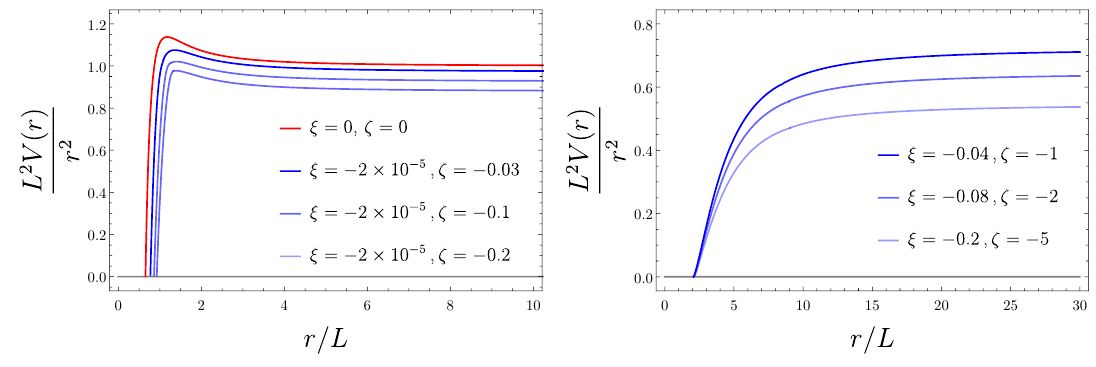
Figure 13 . The metric function L 2 V CP 2 ( r ) =r 2 is plotted for bolt solutions of the quartic theories. The left plot is for di(cid:11)erent combinations of the quartic couplings with n=L = 7 = 100. For this value of the NUT parameter, the bolt solutions in the quartic theories can be compared to Einstein gravity solutions. In the right plot, the NUT parameter has been set to n=L = 2. For this value of the NUT parameter there are no bolt solutions in Einstein gravity and the existence of these solutions is purely because of the quartic curvature